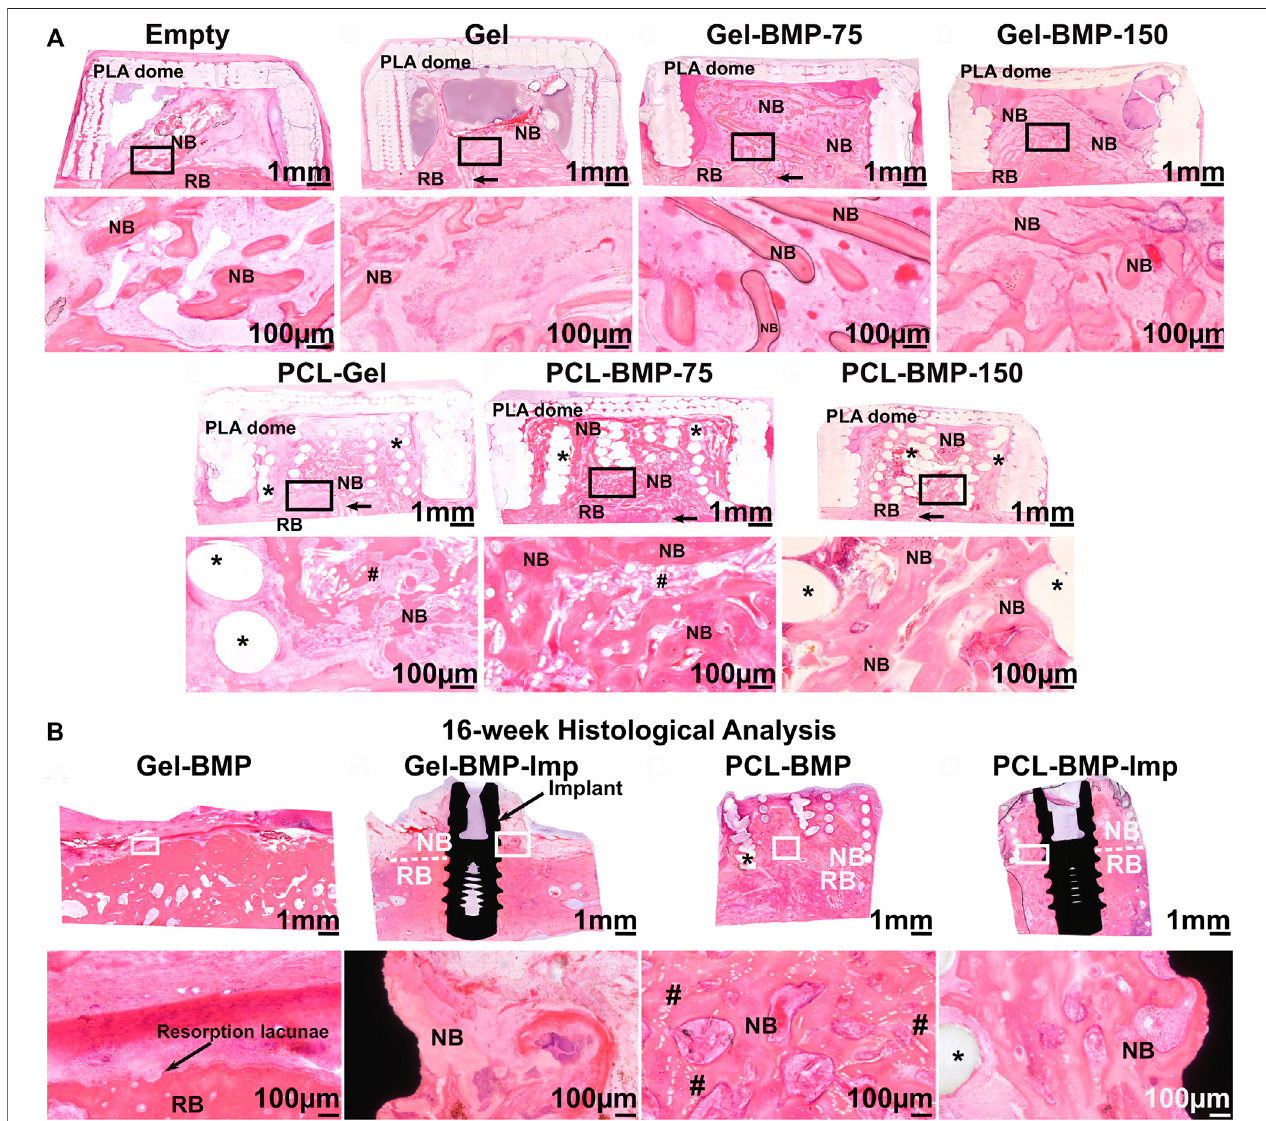
FIGURE 8 | Ef fi cacy of a biphasic scaffold fabricated by converging two additive manufacturing technologies (3D printing for the outer shell provides mechanical stability and melt electrospinning writing for the inner portion imparting high porosity, thereby facilitating vascularization, and bone formation) (A) : Extraskeletal bone formation using an ovine calvarium onlay graftmodel, demonstrating the necessity ofBMP-2to achieve signi fi cant bone formation and showing that the presence of the scaffold resulted in enhanced osteogenesis due toits excellent Gel/BMP-2 retention ability. (B) : Assessment ofbone maintenance subsequent to surgicalre-entry and implant placement in the previously vertically augmented bone. This revealed that the presence of the biphasic scaffold prevented early bone resorption which is a frequent event upon implant placement. Reproduced with permission from (Vaquette et al., 2021).